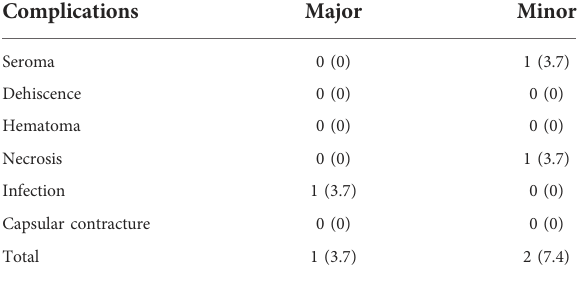
TABLE 2 Complications divided into minor